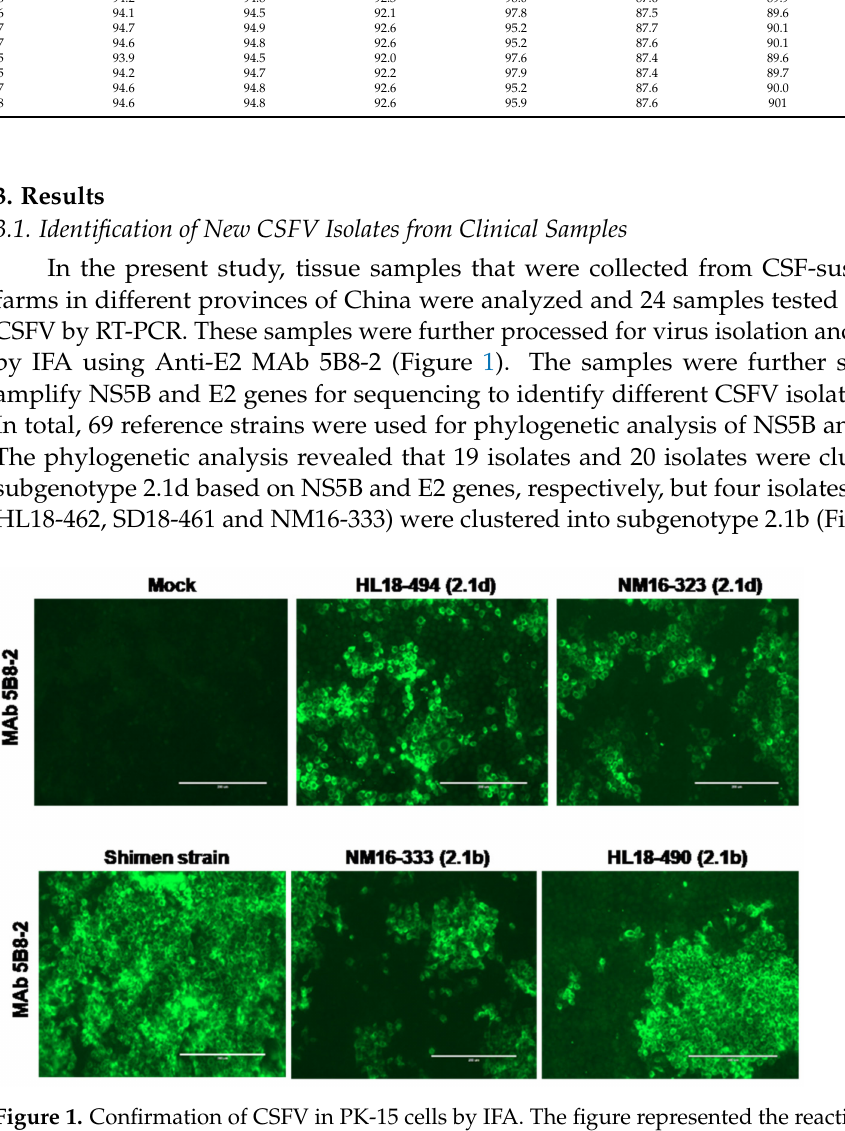
Table 3. Nucleotide sequence identities of the new isolates with nine reference strains based on the full genome. NewIsolated Strains